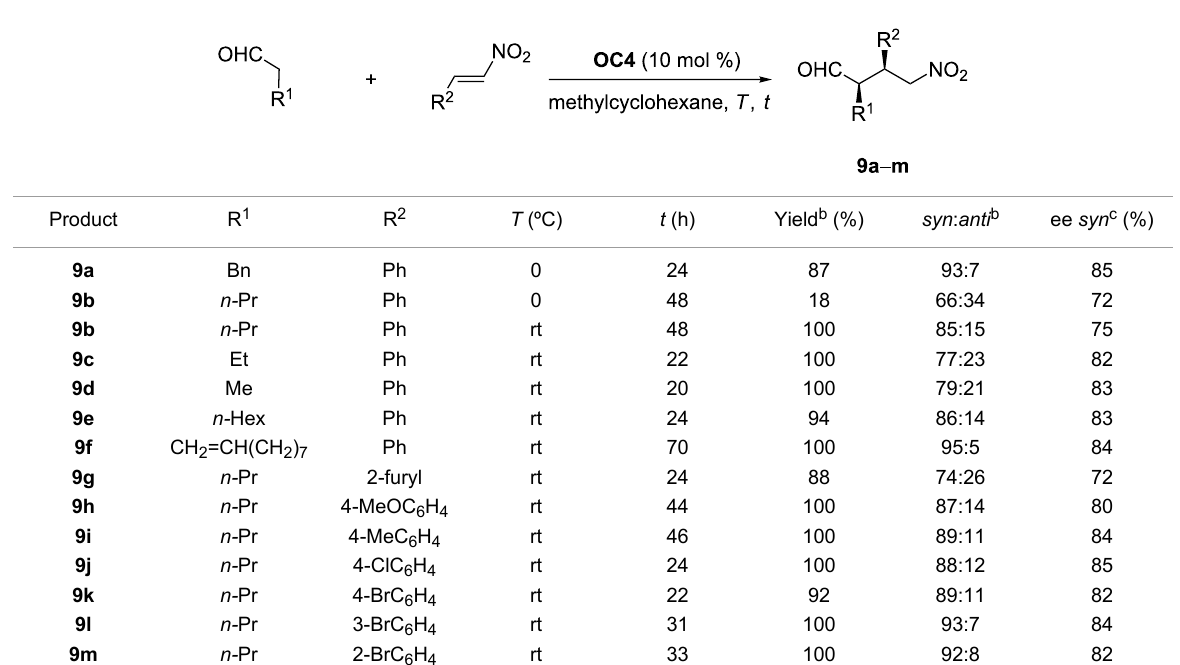
Table 6: Scope of Michael addition of aldehydes to trans - β -nitroolefins using catalyst OC4 . a